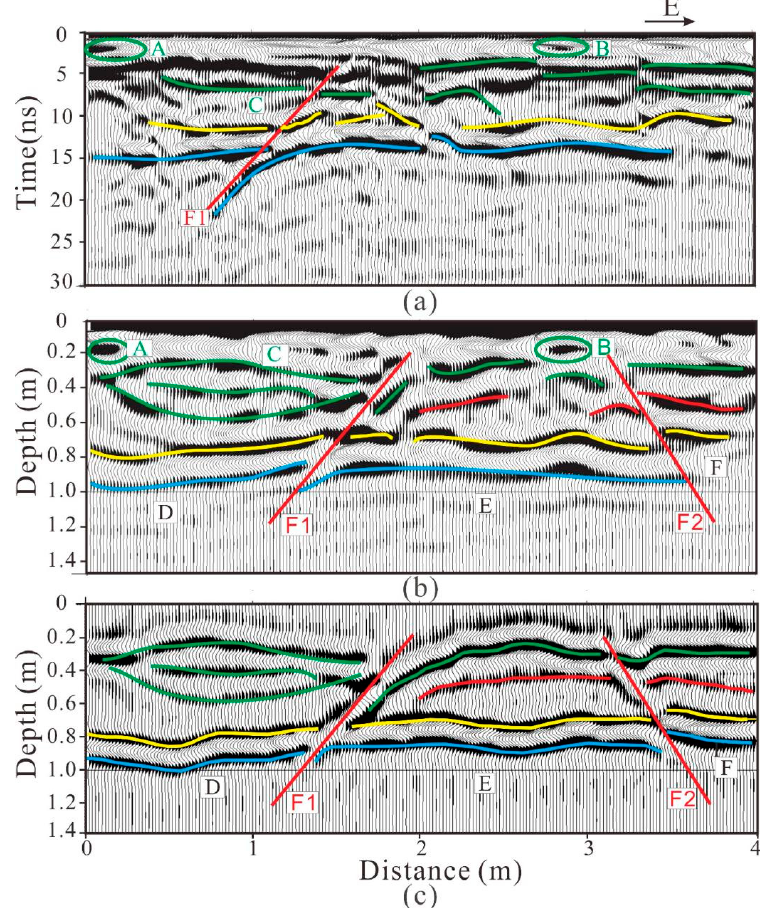
Figure 10. The imaging of migration of L2 line part profile. ( a ) Radar profile; ( b ) real data RTM profile; ( c ) model data RTM profile.